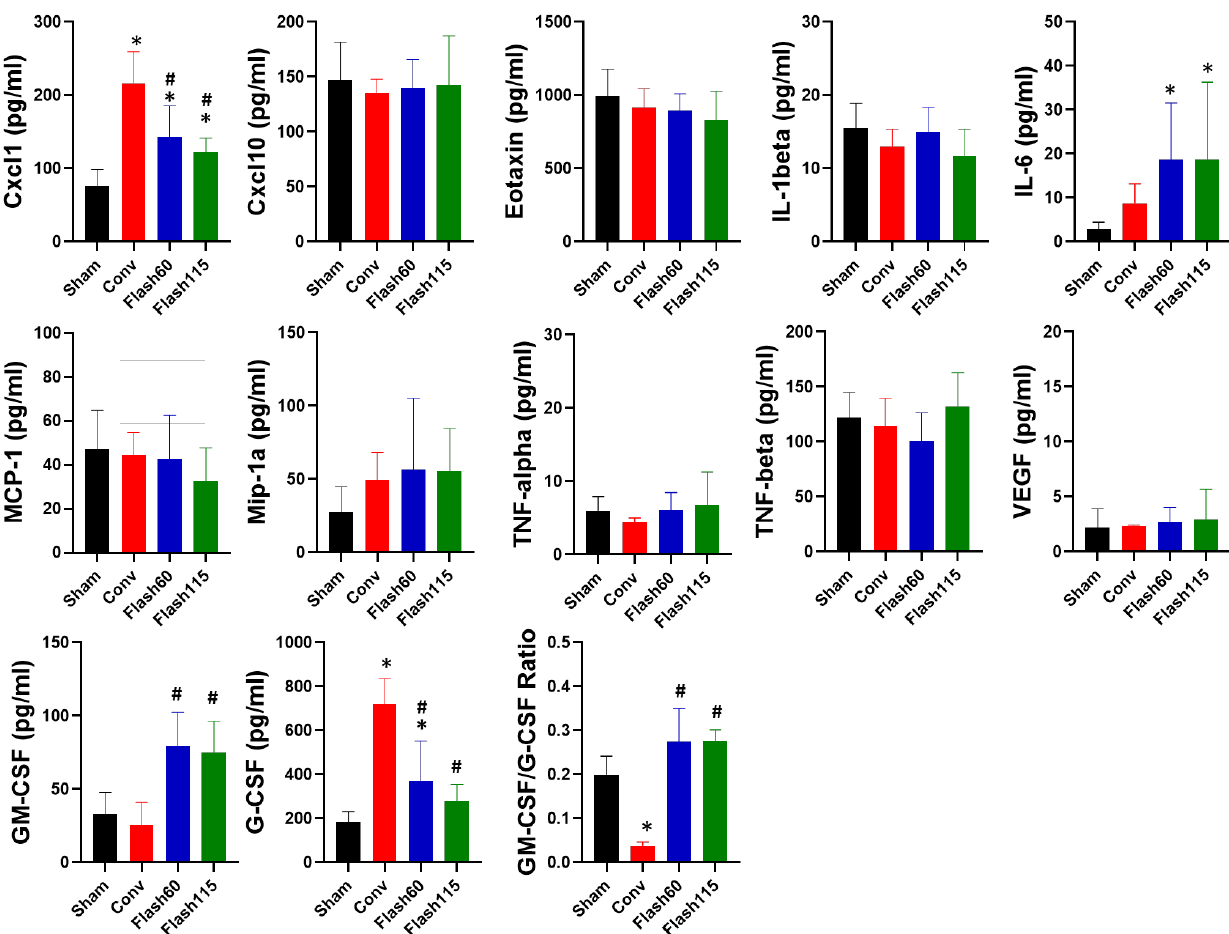
Figure 4. Cytokine response to FLASH PBS- versus Conv-treated mice. Right hind legs of the mice were PBS-irradiated with 35 Gy or left untreated (Sham control mice) with dose rates of 1 Gy/s (Conv), 57 Gy/s (Flash60) and 115 Gy/s (Flash115). Blood was collected at 12 weeks post radiation and the levels of 12 cytokines were quantified by multiplex array ( n = 8/group). Differences between conditions were determined by a one-way ANOVA test with multiple-comparison Tukey correction. * p ≤ 0.05 vs. Sham and # p ≤ 0.05 vs. Conv. Bars represent mean +/− SD.